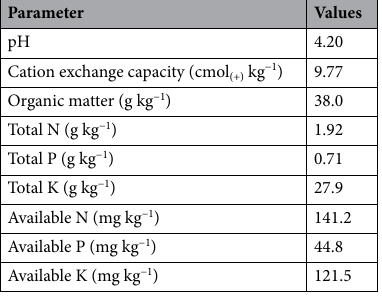
Table 1. Physical and chemical properties of the test soil (0–20